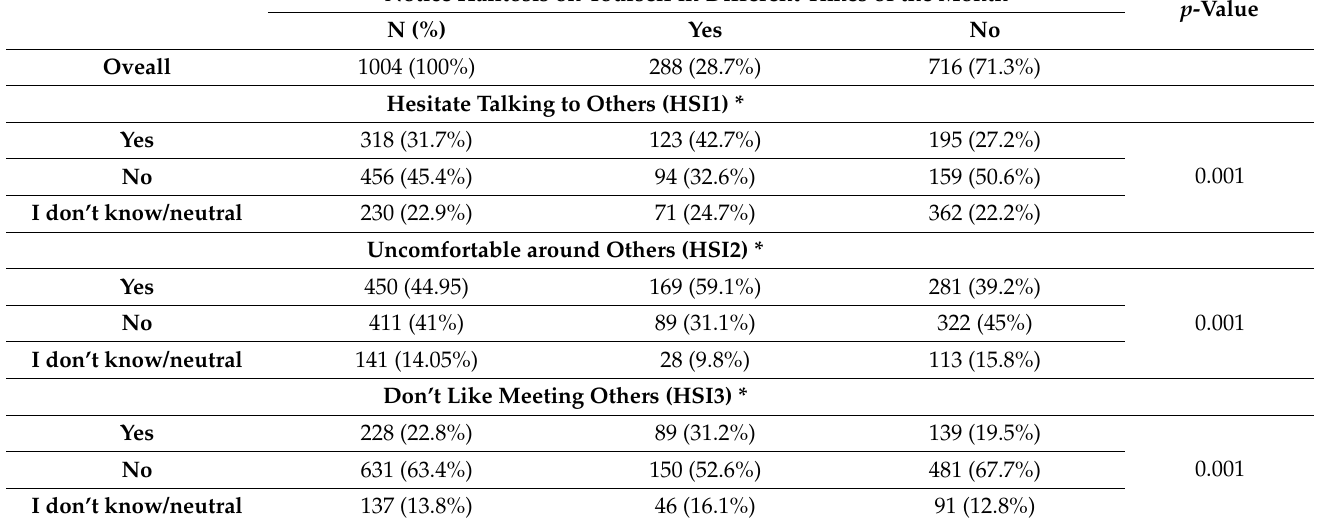
Table 6. Association of the social impact and noticing halitosis on yourself in different time of the month.